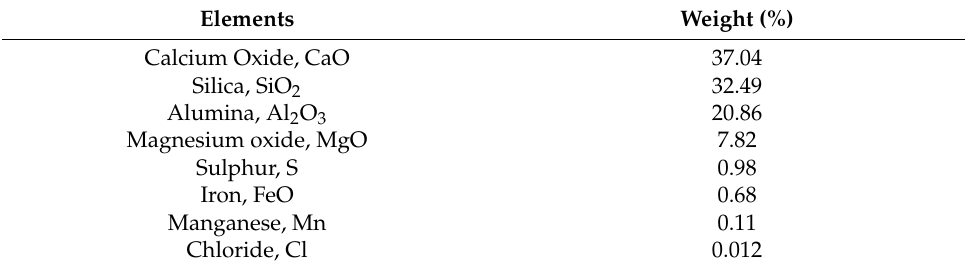
Table 2. Chemical composition of